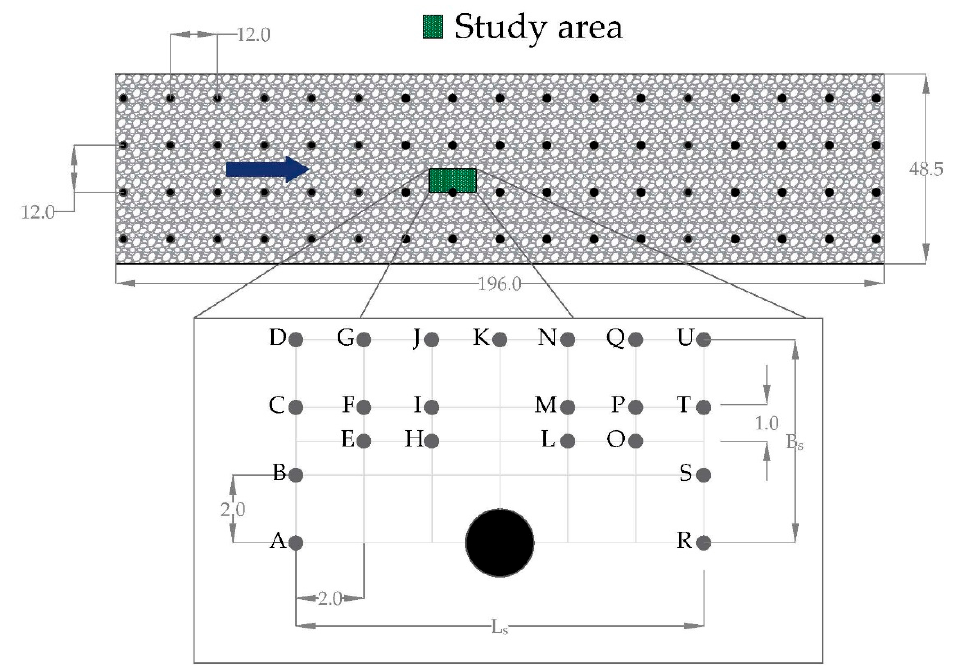
Figure 1. Sketch of the flume with the cylinders array (dimensions are in cm); in the inset, the measurement points within the study area were indicated with the letters from A to U. Here, B s and L s are the width and length of the study area.